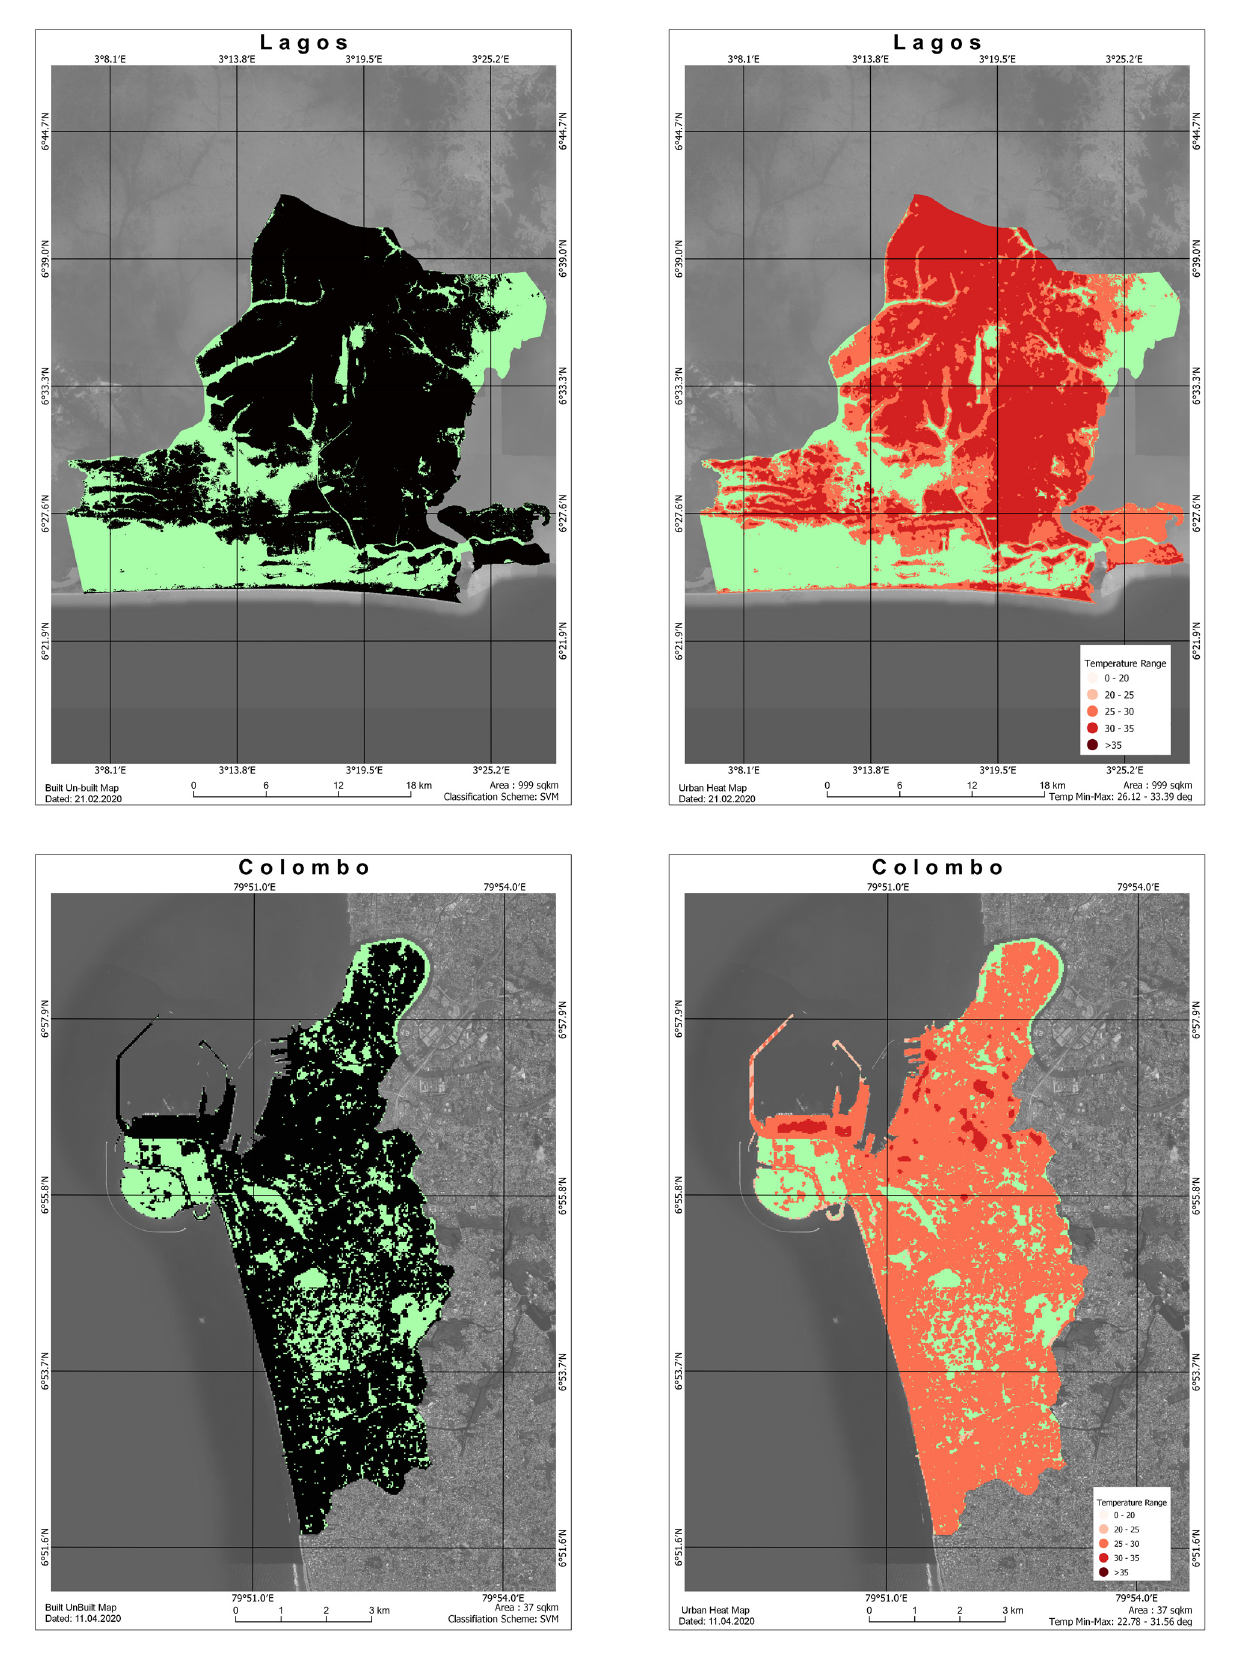
Figure 3. Built (black)/unbuilt (green) map with a corresponding heat map for both a megacity and its respective mid-sized city in a low-latitude region (Lagos and Colombo).